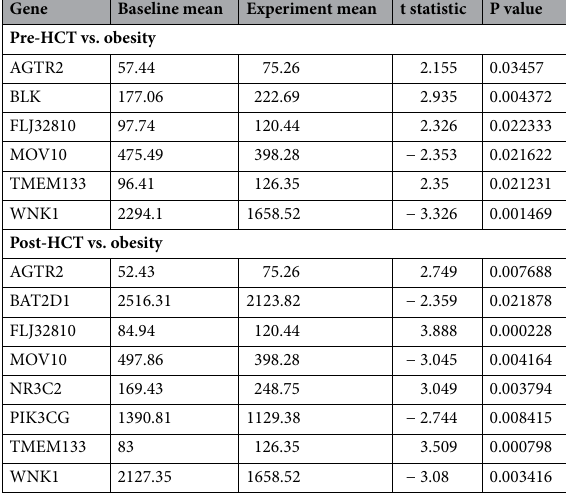
Table 7. Statistically significant differences of gene expressions between pre-HCT and post-HCT groups and the obesity control group.